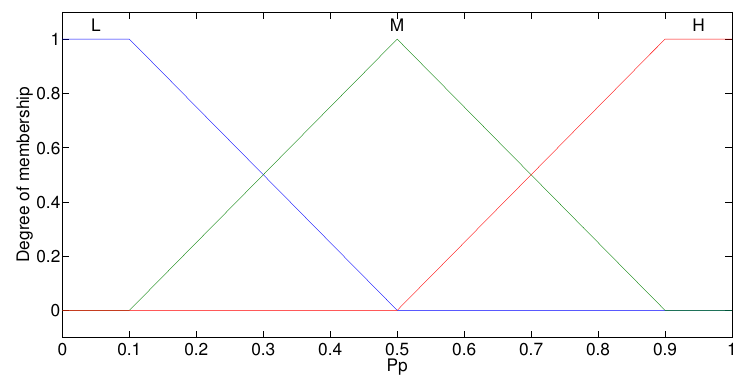
Figure 2. Membership functions of the fuzzy input P p .